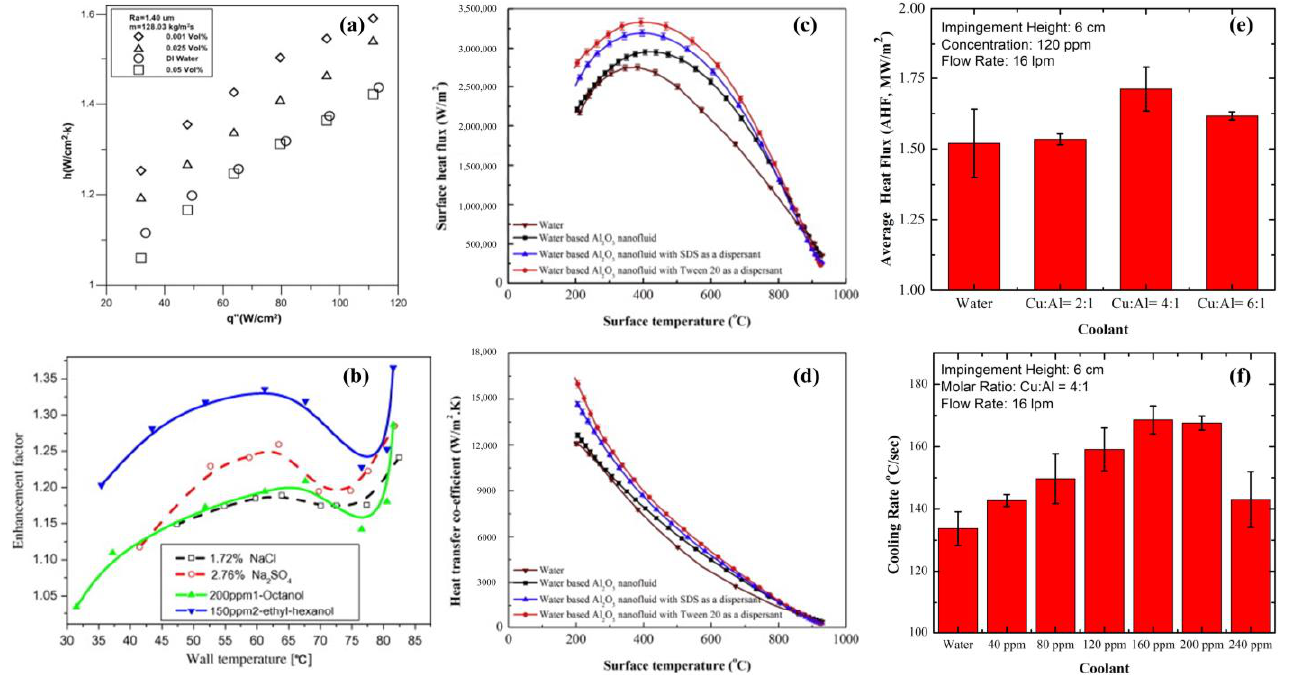
Figure 6. Research on the heat exchange effect of jet cooling based on working medium modification. ( a ) Variation of heat transfer coefficient with surface heat flux as function of particle volume fraction for test surface roughness of 1.4 μm [106]. ( b ) The relationship between enhancement factor and wall temperature in four additives; different cooling medium atomized spray cooling surface temperature and ( c ) surface heat flux; ( d ) heat transfer coefficient [107]. Comparison between ( e ) AHF values, ( f ) CR values achieved by different Cu and Al molar ratios of Cu-Al LDH nanofluid at the temperature of 600 – 900 °C [109].